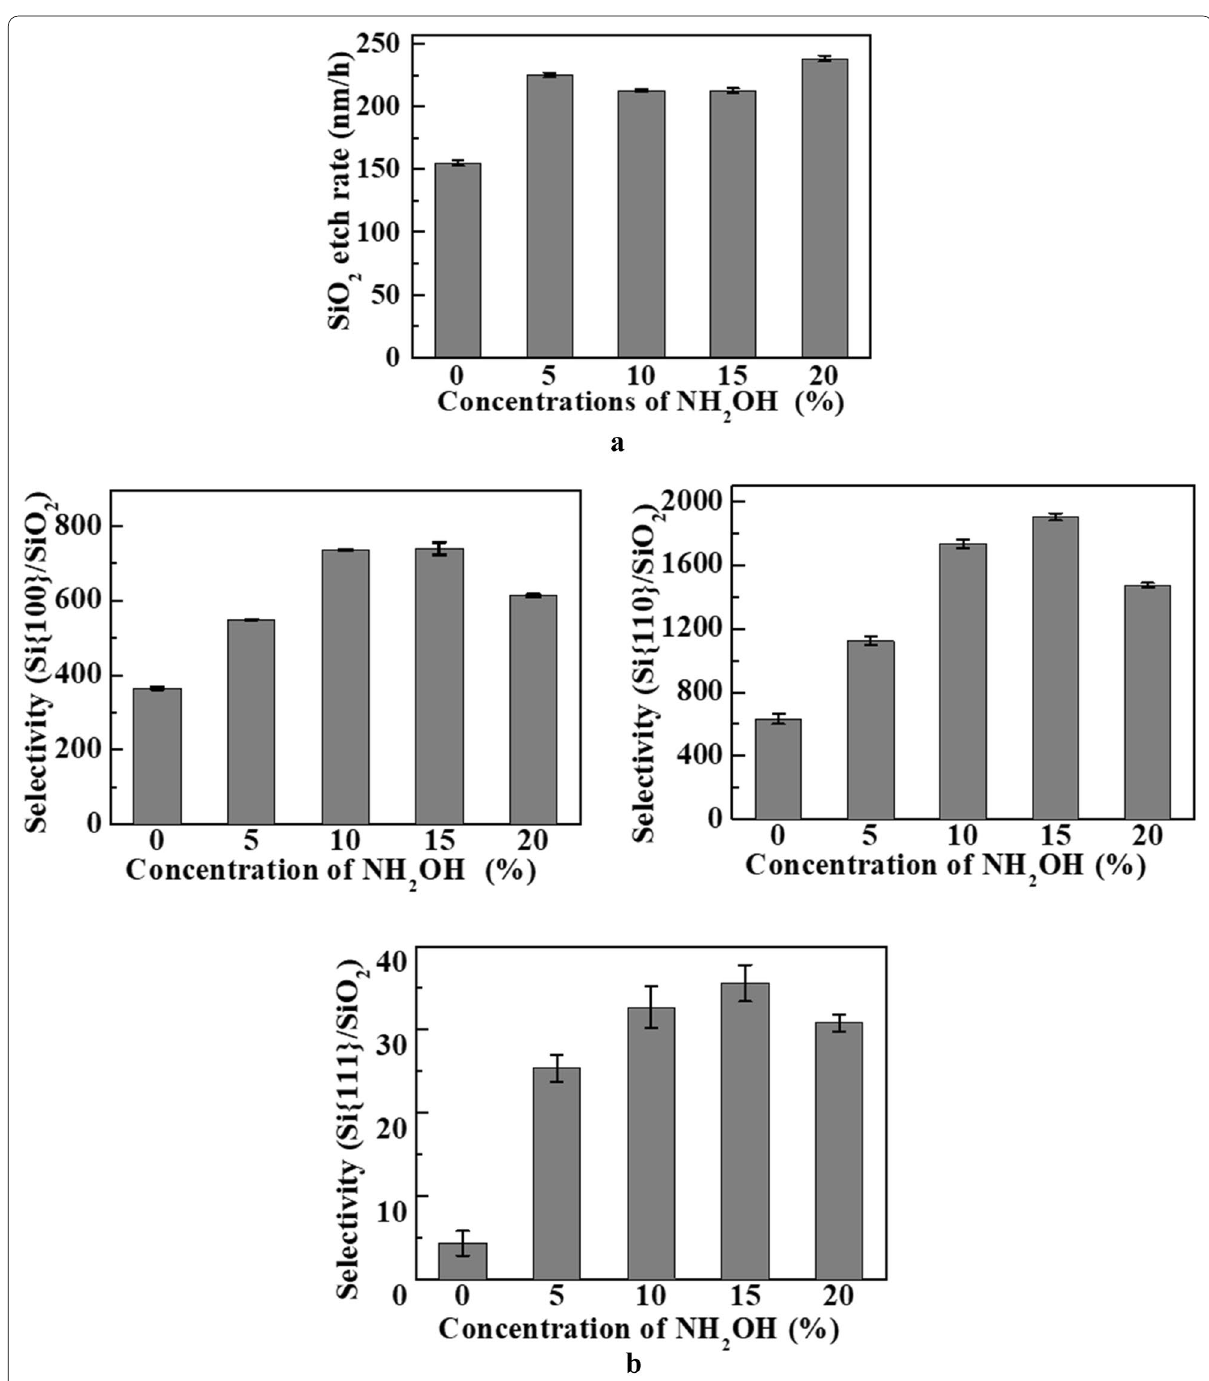
Fig. 33 a etch rate of silicon dioxide and b the etch selectivity between silicon and silicon dioxide (R Si /R SiO2 ) in 20 wt% KOH at 75 and with varying concentrations of